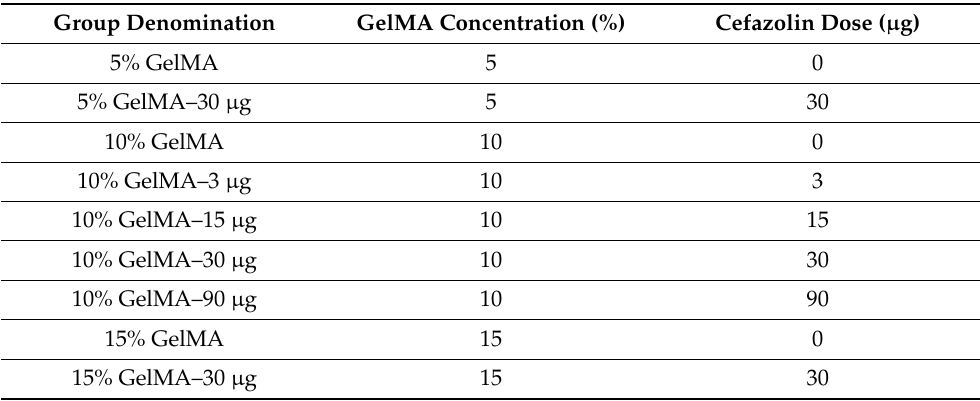
Table 1. Experimental groups denomination and